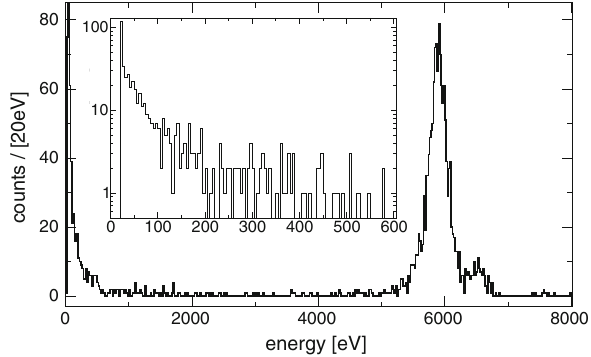
Fig. 2 Total energy spectrum of the 5.3h measurement in presence of the 55 Fe X-ray source with peaks at 5.90 and 6.49keV. The inset shows the events in the region-of-interest for DM search from the energy threshold of 19.7–600eV (binning 5eV). No data quality cuts are